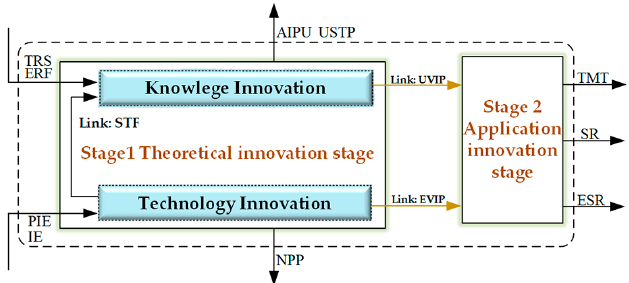
Figure 1. Flow chart of the PEBM